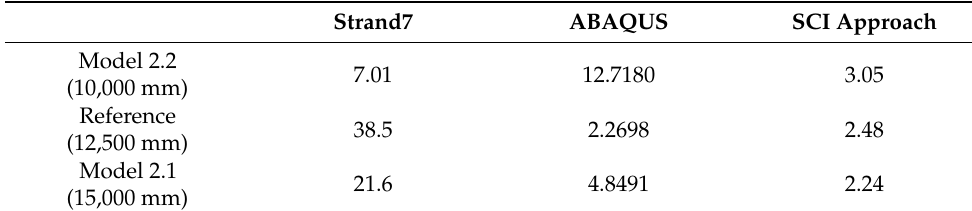
Table 11. Comparison of Response Factor between Different Primary Beam Lengths.